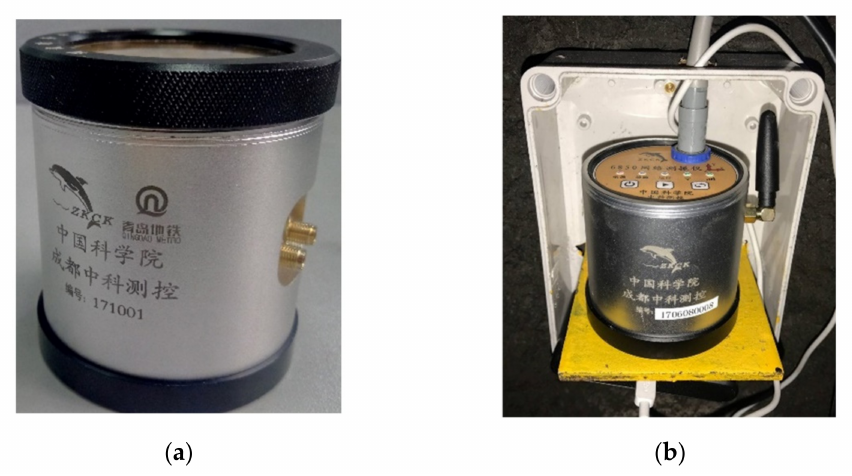
Figure 1. ( a ) The network vibrometer: TC-6850; ( b ) The site installation of TC-6850.